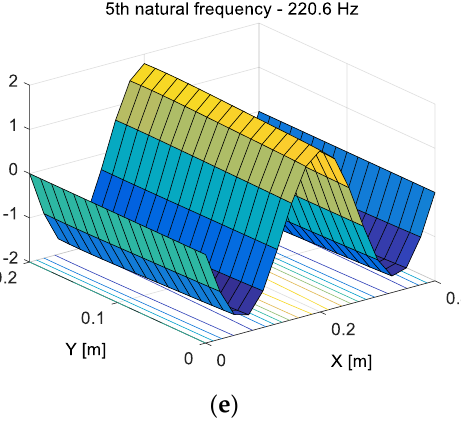
Figure 2. The first five mode shapes of the host structure with a piezo-harvester and piezo-actuators.